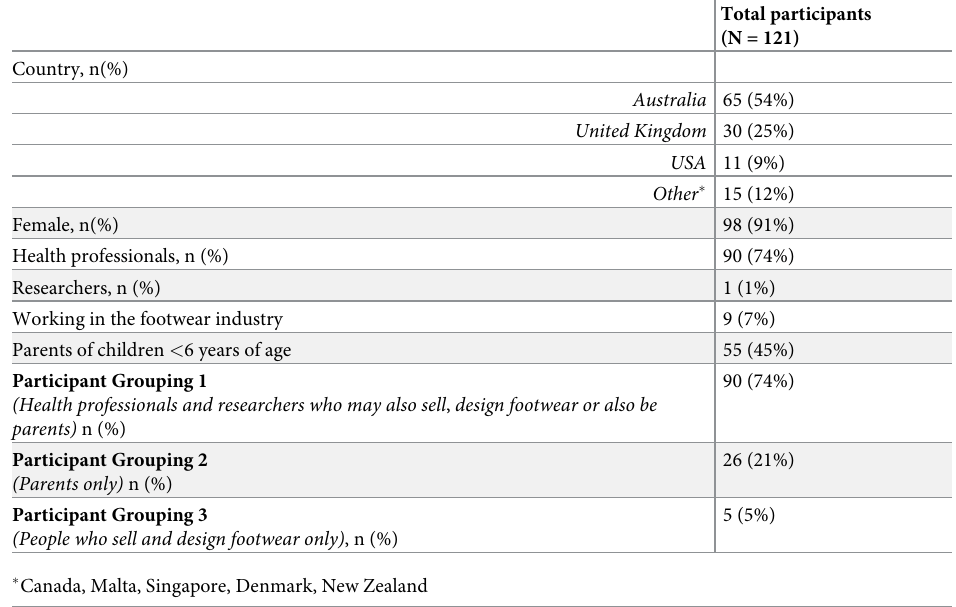
and 4 provide all statements generated by participants and the frequency (%) of participants who provided the same response. Statements highlighted in green were those that meet con- sensus ( � 70% of all participants providing the same response). There were 71 statements where less than 50% of participants described content, these were discarded at Round 1, and highlighted in red in Tables 3 and 4. Statements highlighted in orange in Tables 3 and 4 were developed from similar statements from 50–69% of participants in total, or in each participant group and progressed to the next round.